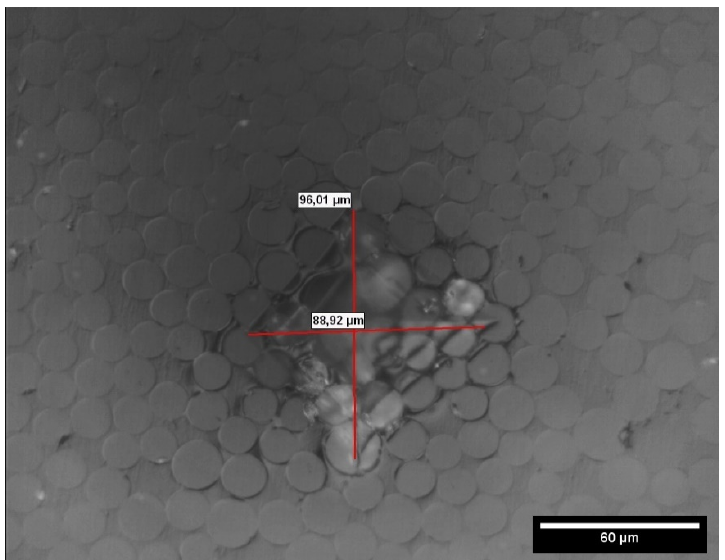
Figure 17. Image of an indenter imprint on the flat side surface of sample A2, 500×. In order to measure it correctly, the position of the markers was manually corrected. The measured values of the imprint diameter were averaged. There are no common microcracks running from the apex of the imprint, but there are visible fiber cracks as a result of the indenter operation.